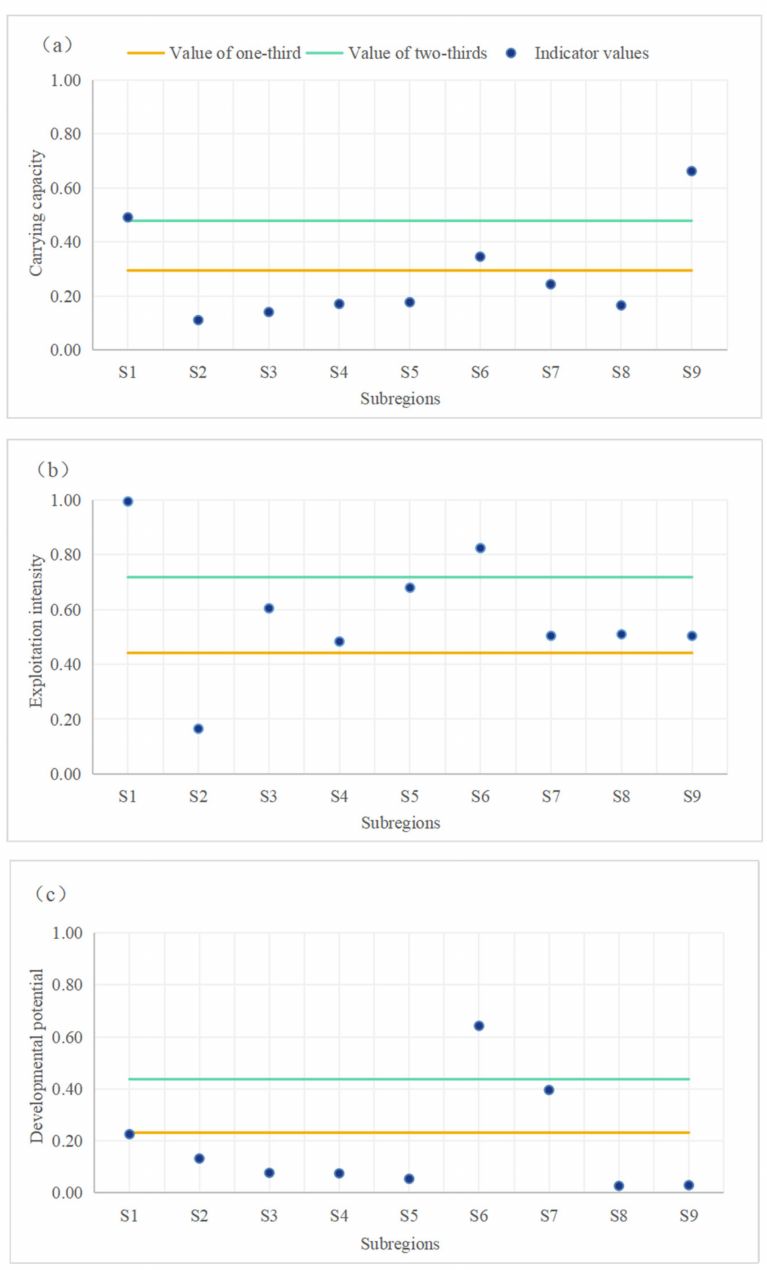
Figure 6. Results of the grade determination: values < one-third are at low levels, values > two-thirds are at high levels, while values between them are at a medium level: ( a ) marine resources and envi- ronmental carrying capacity, ( b ) marine exploitation intensity, ( c ) marine developmental